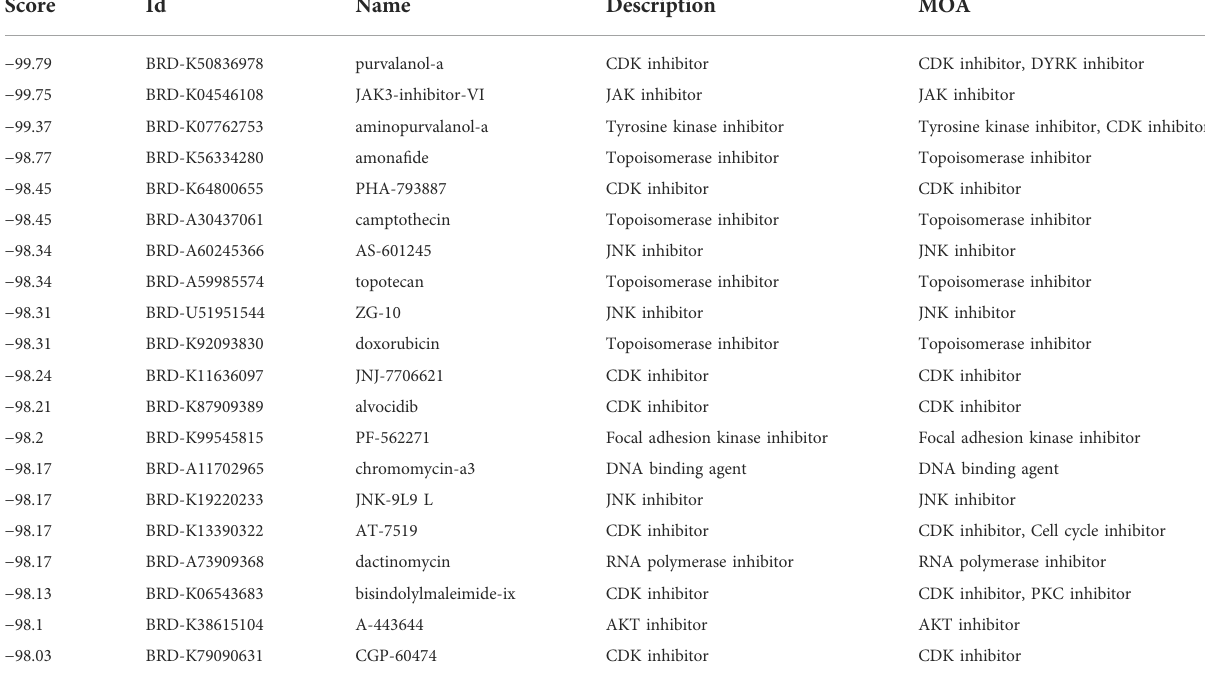
TABLE 2 The top 20 candidate drugs based on the DEGs in the GEO